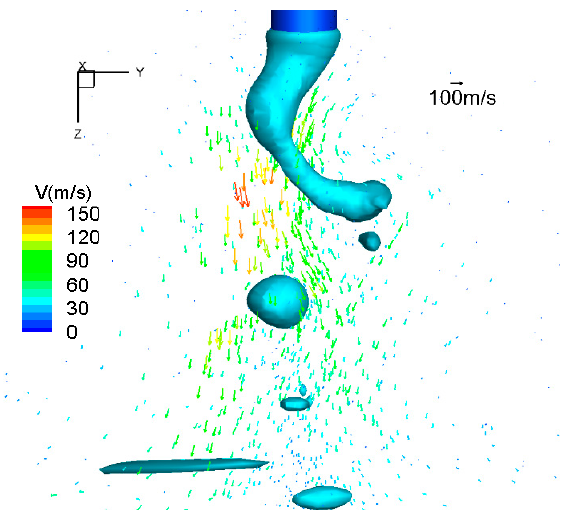
Figure 6. Arc plasma flow velocity vector for high-current GMAW.